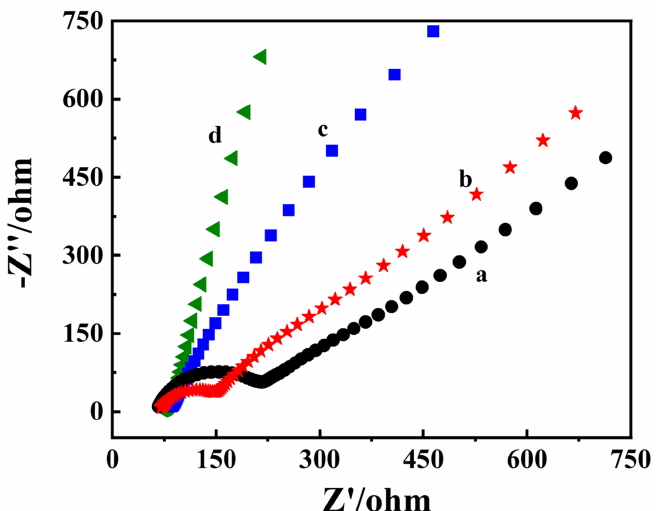
Figure 3. EIS of ( a ) SPE, ( b ) ND/SPE, ( c ) BP/SPE, and ( d ) ND@BP/SPE in a 10.0 mmol/L [Fe(CN) 6 ] 3 − /4 − and 0.1 mol/L KCl mixture, with frequencies ranging from 10 5 to 10 − 2 Hz and an amplitude of 5 mV.